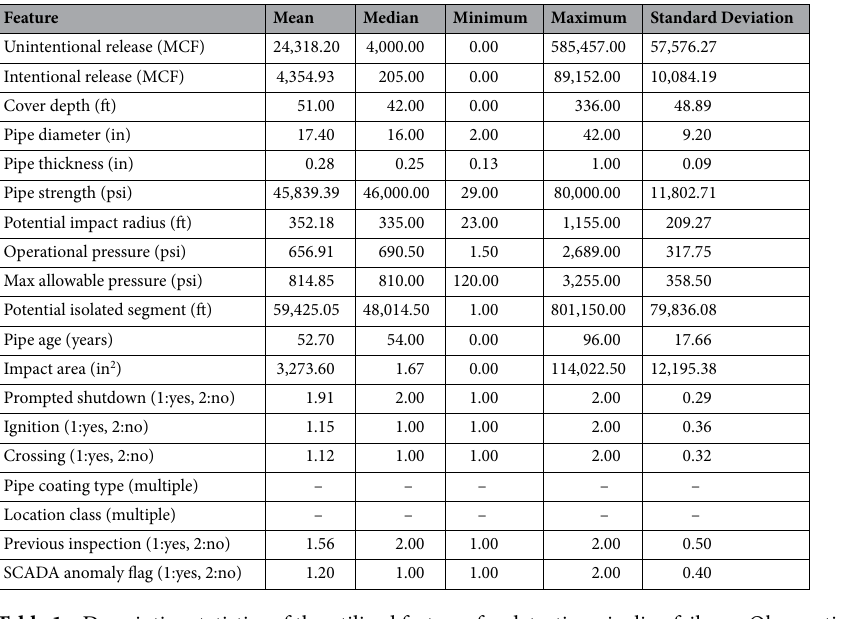
Table 1. Descriptive statistics of the utilized features for detecting pipeline failures. Observations with partially available information are included in the dataset used to generate the statistics. The training and testing datasets are normalized before proceeding to the proposed CIC